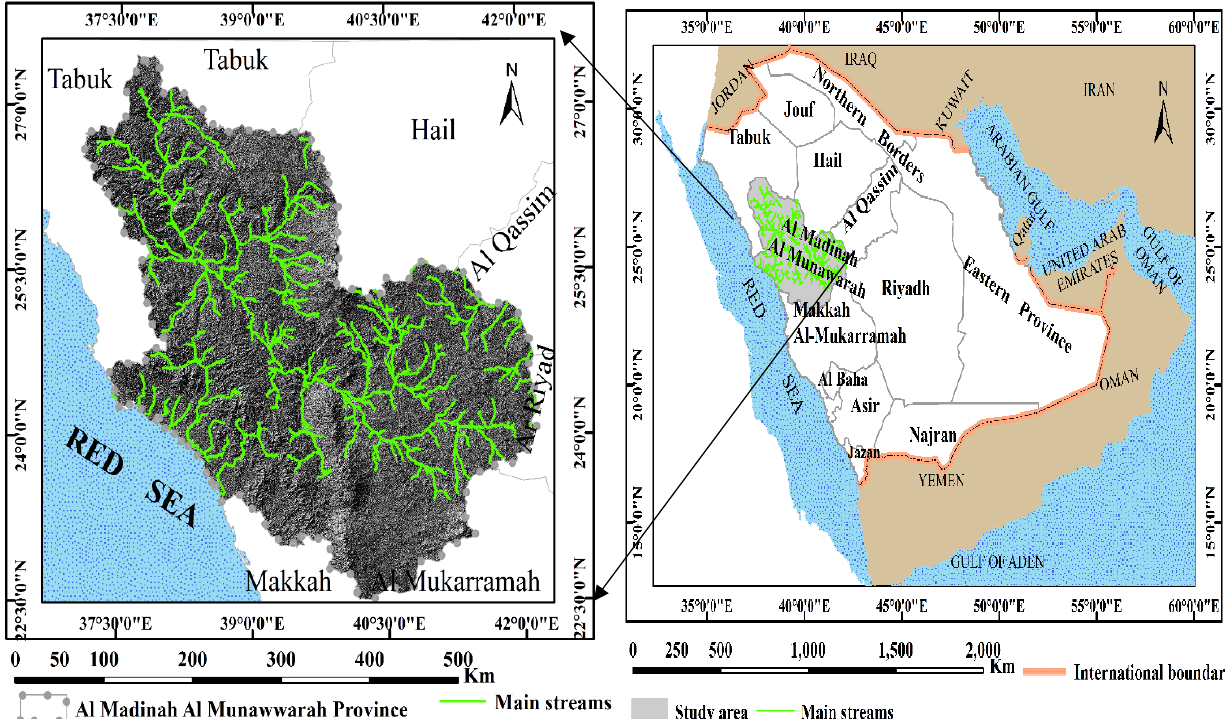
Figure 1. Location map of Al Madinah Al Munawarah Province.